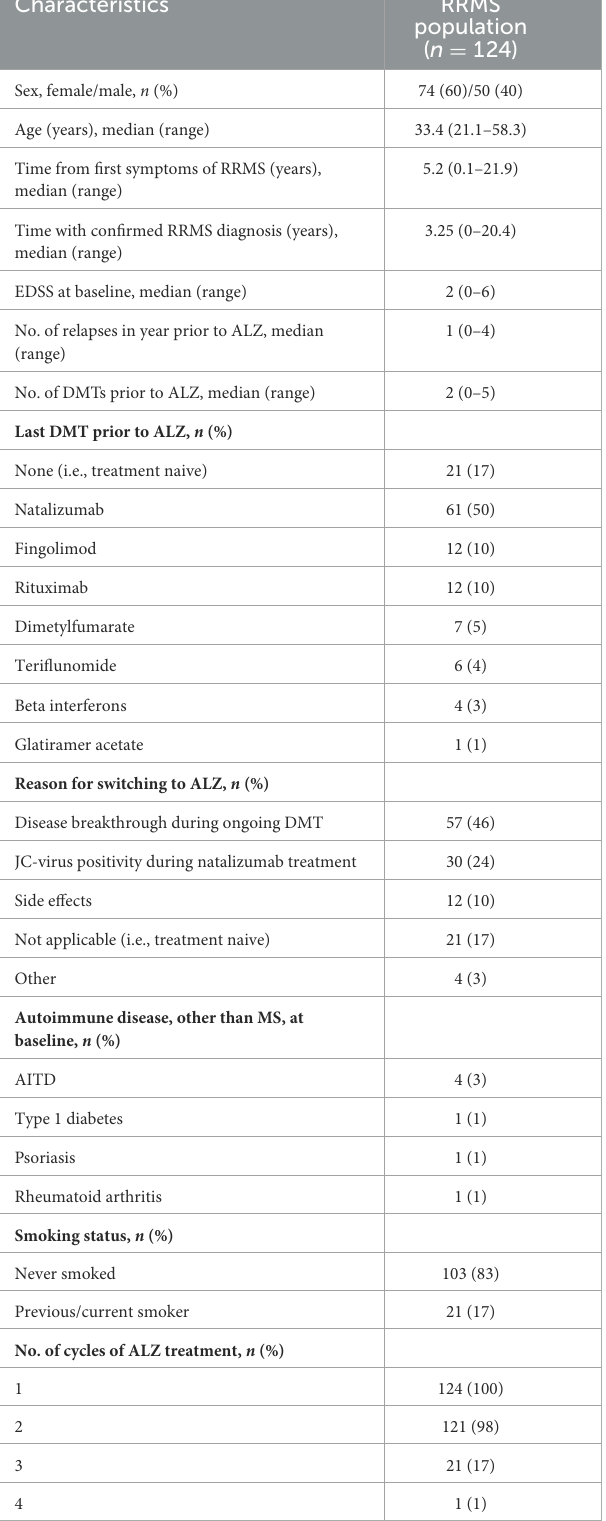
TABLE 1 Clinical and demographic characteristics of patients with RRMS treated with ALZ.